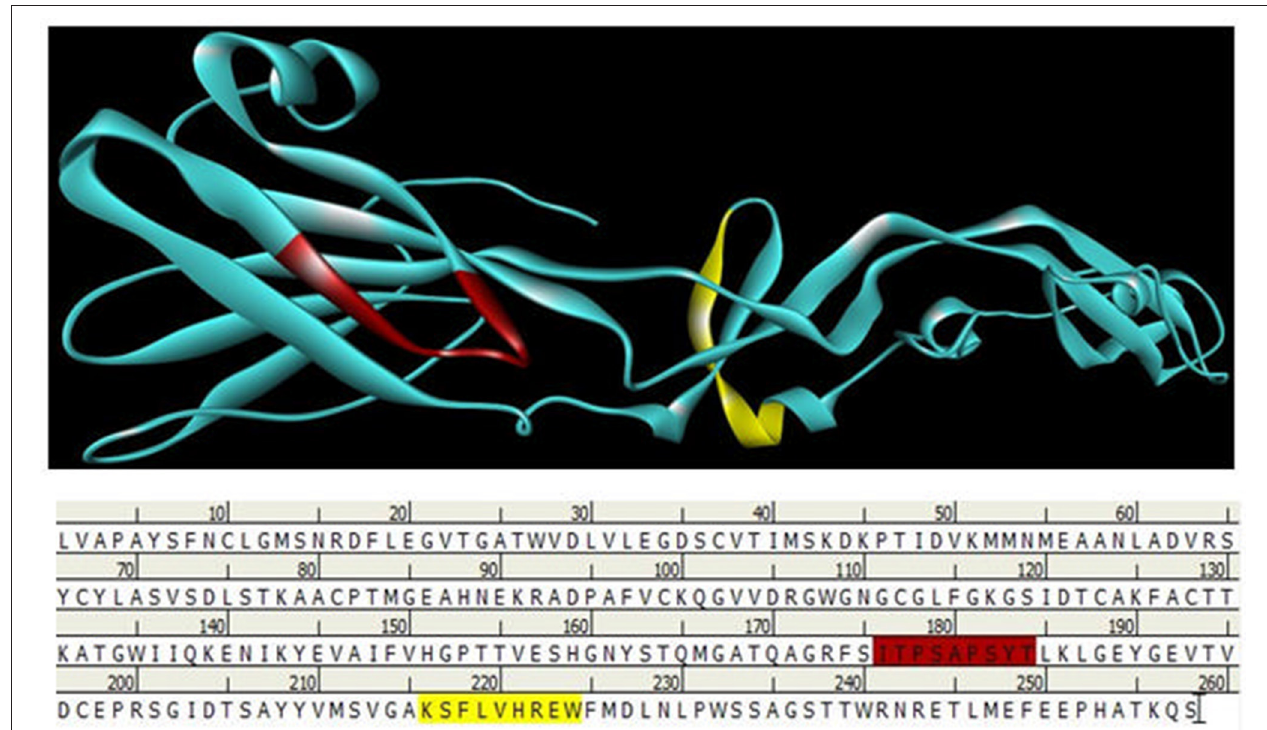
FIGURE 5 | B and T cell epitopes depiction of envelope glycoprotein. Here red color indicates B cell epitope in 176–184 regions and Yellow color indicates T cell epitope is 216–224 regions.